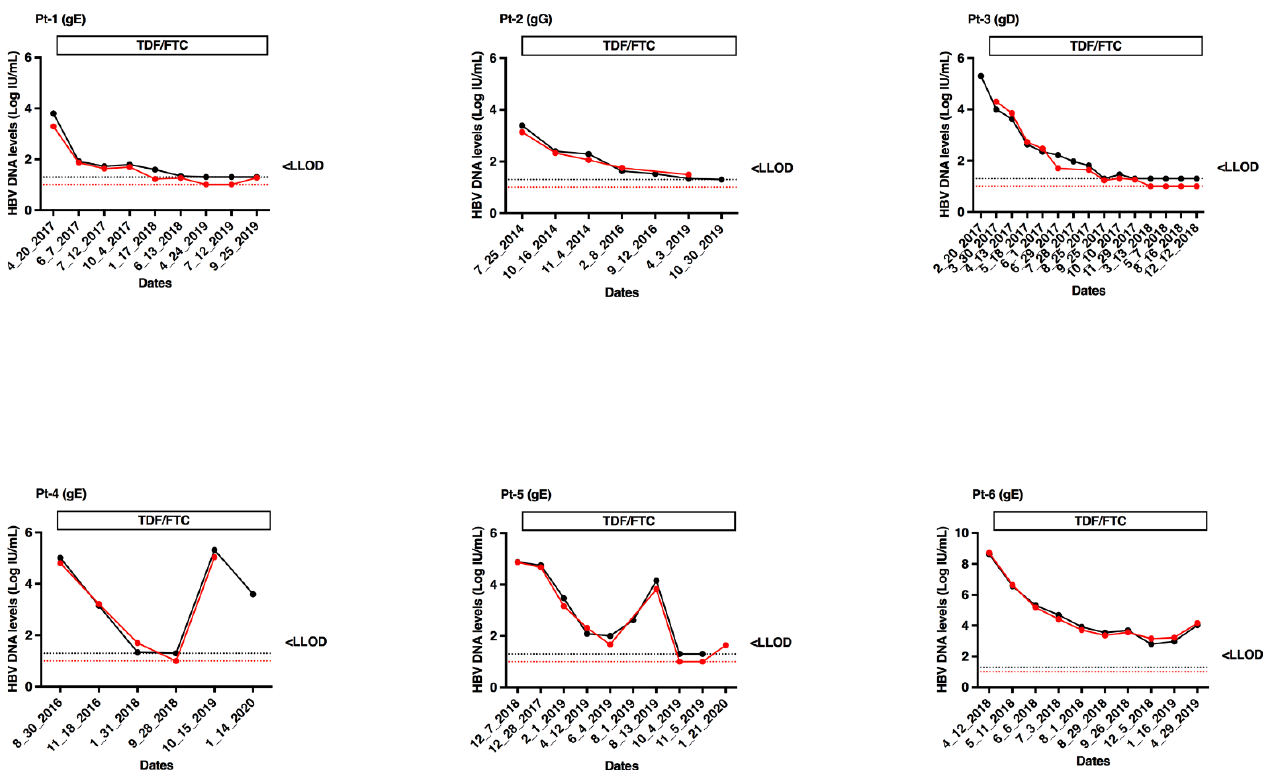
Figure 4. Kinetics of HBV DNA levels measured with cobas ® HBV Test (red lines and filled circles) and CAP/CTM HBV Test v2.0 (black lines and filled circles) in treated patients with tenofovir-containing regimens. The red and black dashed lines correspond to the LLOQ of cobas ® HBV Test (1.0 Log IU/mL) and CAP/CTM HBV Test v2.0 (1.3 Log IU/mL), respec- tively. Pt, patient; TDF, tenofovir; FTC, emtricitabine; gE, genotype E; gG, genotype G; gD, genotype D.